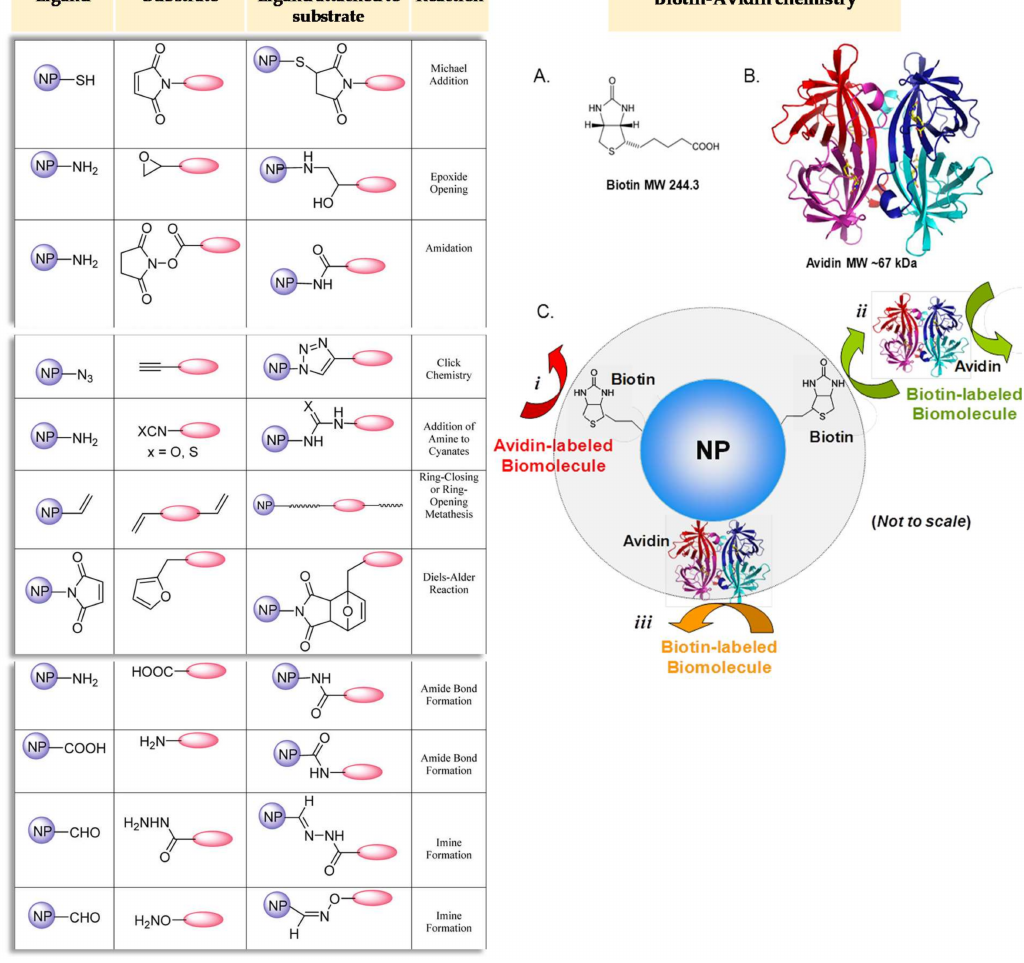
Figure 1. Selected nanoparticle (NP) functionalization chemistries. Biotin − avidin chemistry. (A) Chemical structure of biotin. (B) a ribbon model of tetrameric avidin, showing the monomers in magenta, blue, cyan and red and the four biotin molecules in yellow. (C) Scheme showing the three commonly used biotin − avidin strategies for attaching biomolecules to NPs: (i) Biotin-labelled NP coupled to avidin-labelled biomolecule; (ii) Biotin-labelled NP coupled to a biotin-labelled biomolecule by an avidin linker; (iii) Avidin-labelled NP coupled to a biotin-labelled biomolecule. Reprinted with permission from [50]. Copyright 2013 American Chemical